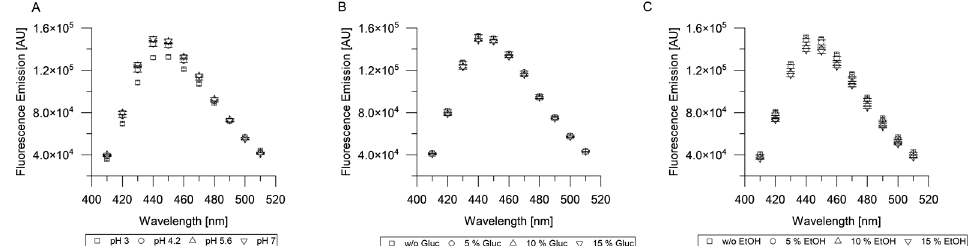
Figure 5. Investigation of 4-MU fluorescence variation due to changes of pH and ethanol or glucose addition. The absorption spectra illustrate the 4-MU emission spectra at ( A ) different pH values, ( B ) different concentrations of glucose or ( C ) different concentrations of ethanol. The excitation wavelength was 330 nm. Experiments were conducted in triplicates. The values represent the mean values of three experiments and respective standard deviations. Whereas the addition of glucose did not affect the fluorescence emission, changes in the pH value or ethanol concentration resulted in slight changes of the signal intensity. With decreasing pH values, the fluorescence signal of 4-MUG was reduced from 150,000 units (pH 7) to 130,000 units (pH 3). Moreover, the signal decreased from 150,000 units without the addition of ethanol to about 135,000 units at 15% v/v ethanol.